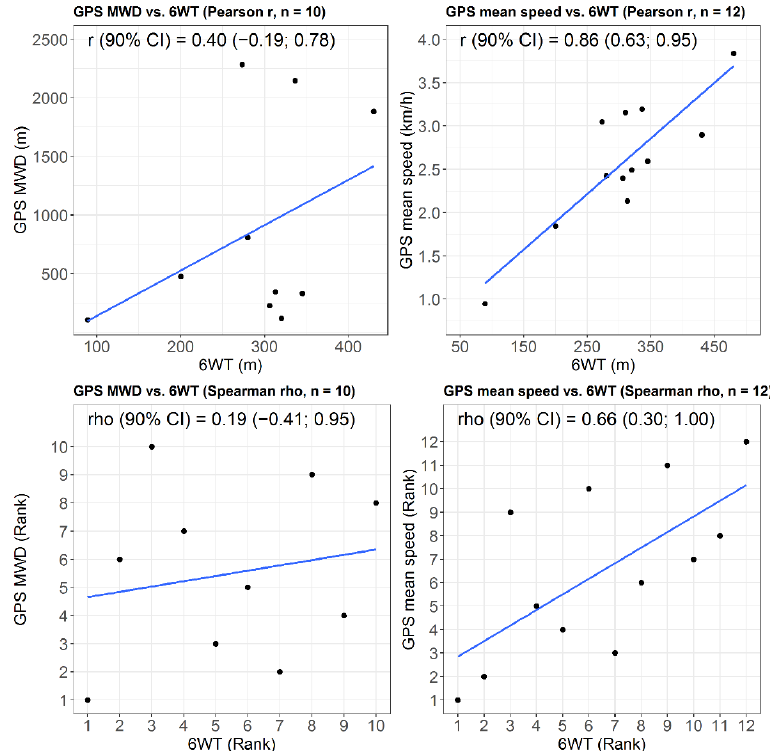
Figure 6. Relationships between outdoor walking capacities and the 6-min total walking distance. GPS MWD = Maximal walking distance measured using GPS during the outdoor walking session; 6 WT = Total walking distance measured during the 6-min walking test.